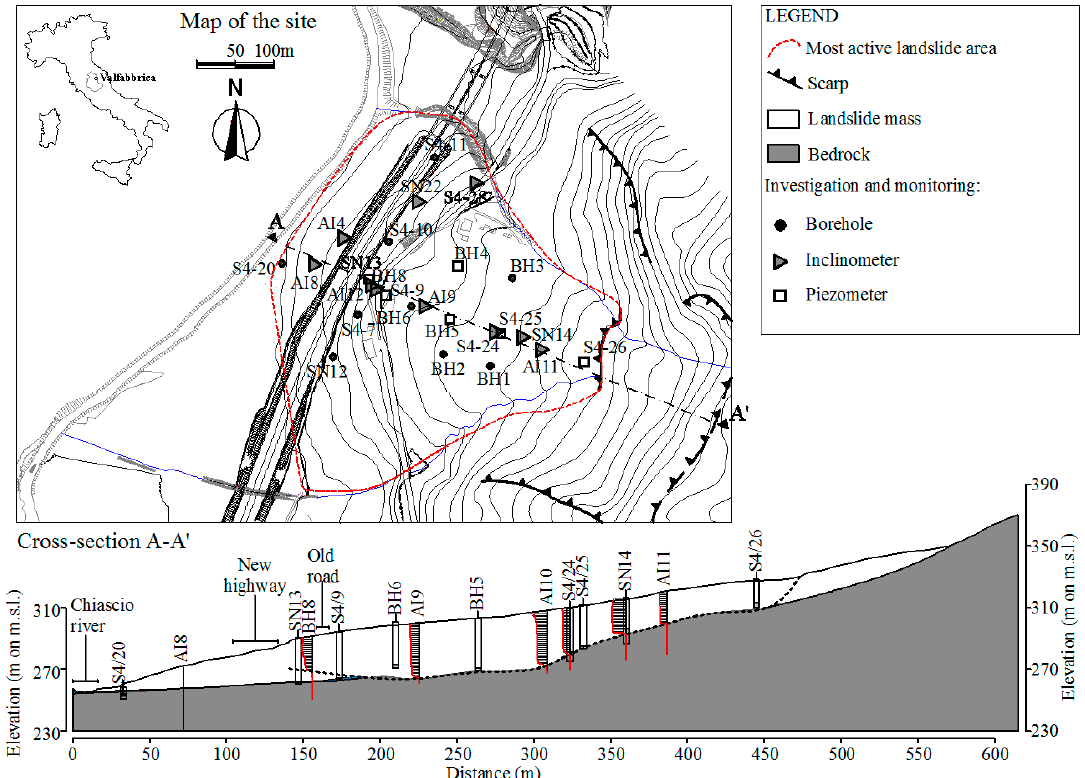
Figure 1. Plan view of the landslide with a longitudinal representative cross section A-A ′ along the slope.